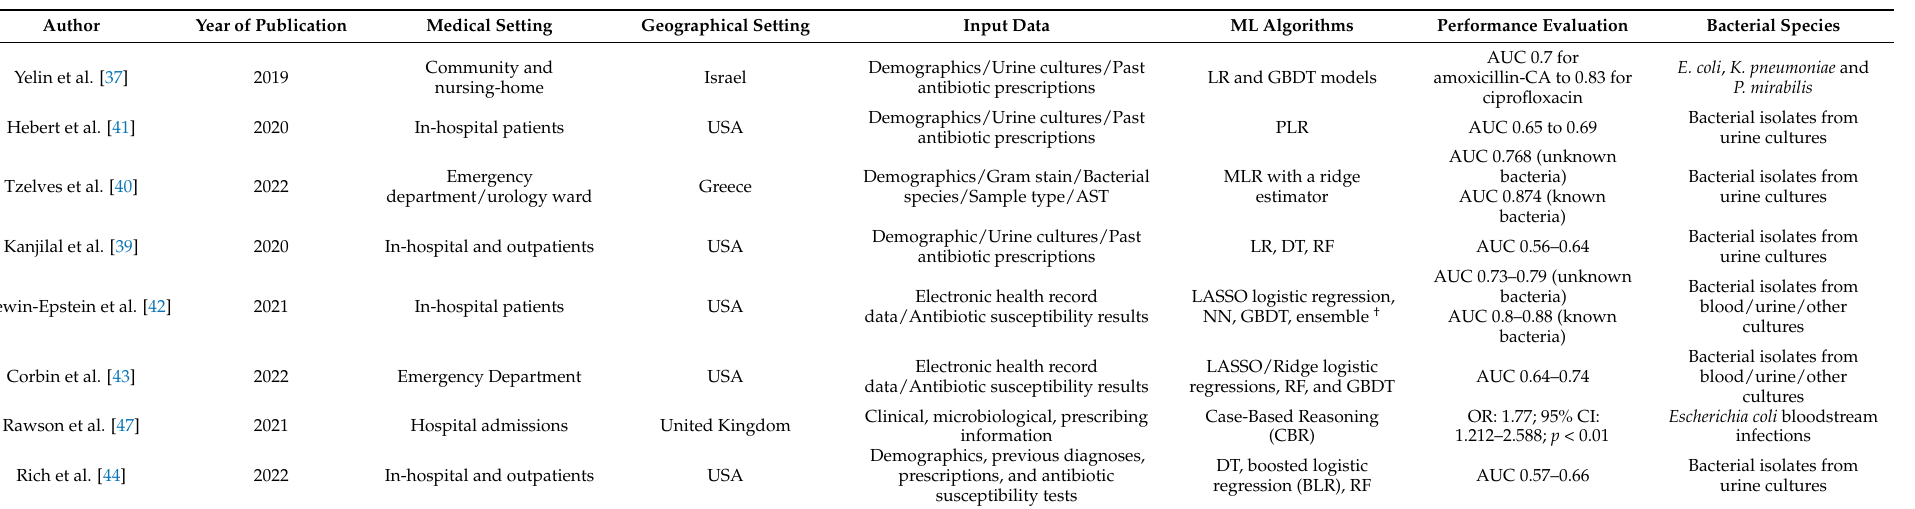
Table 2. Performance of machine learning-Assisted Antibiotic Prescription across different